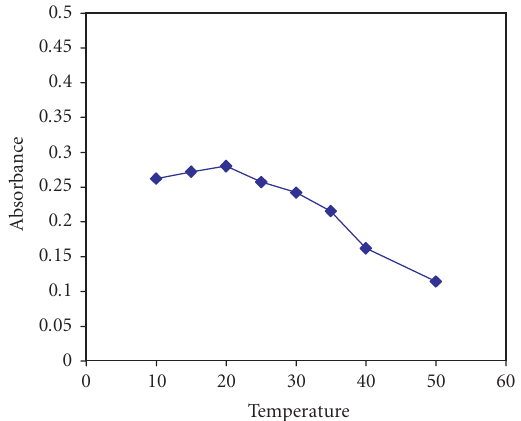
Figure 7. E ff ect of temperature on the absorbance of LD-iodine compound at wavelength =